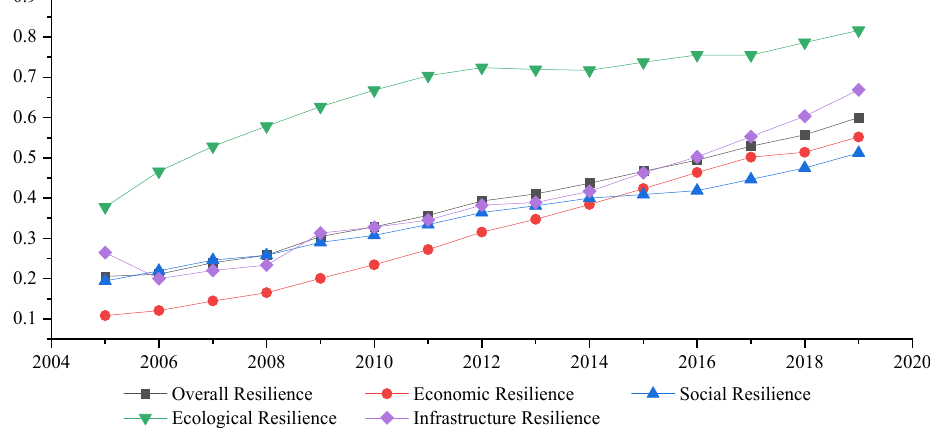
Figure 2. Average value of regional overall resilience and subsystem resilience of the Chengdu– Chongqing urban agglomeration from 2005 to 2019.